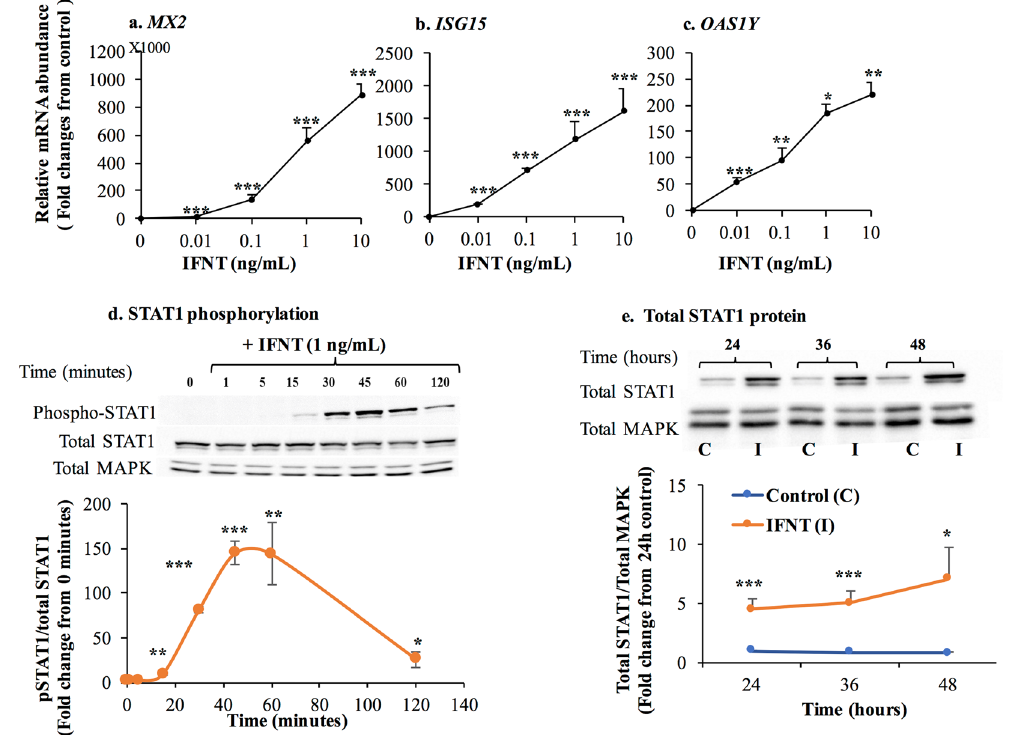
Figure 1. IFNT stimulated STAT1 dependent type-1 interferon pathway in LGCs. ( a – c ) Cells were incubated for 24 h with either basal media (control) or varying concentrations of roIFNT (0.01–10 ng/mL). Cells were then harvested, and the mRNA expression of (A) MX2, ( b ) ISG15 and (C) OAS1Y were determined using qPCR. ( d ) Tyrosine phosphorylated STAT1 (p-STAT1) and ( e ) total STAT1 proteins were analyzed using specific antibodies in western blotting. Representative images of western blots are presented in the upper panels of D and E. Blots in ( d ) were cropped from different gels, blots in ( e ) were cropped from different parts of the same gels. Whole cell extracts from LGCs were incubated with IFNT (1 ng/mL) for different time points as indicated. Quantitative analysis of phospho-STAT1 levels were normalized to total STAT1 and total STAT1 was normalized to total MAPK (p44/42) protein. Asterisks indicate significant differences from either time 0 or basal media (control) or control ( * P < 0.05, ** P < 0.01, *** P <